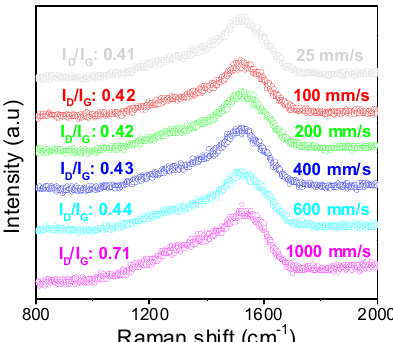
Figure 5. Raman spectra measured on the worn surfaces of the H ‐ DLC films at different sliding velocities.